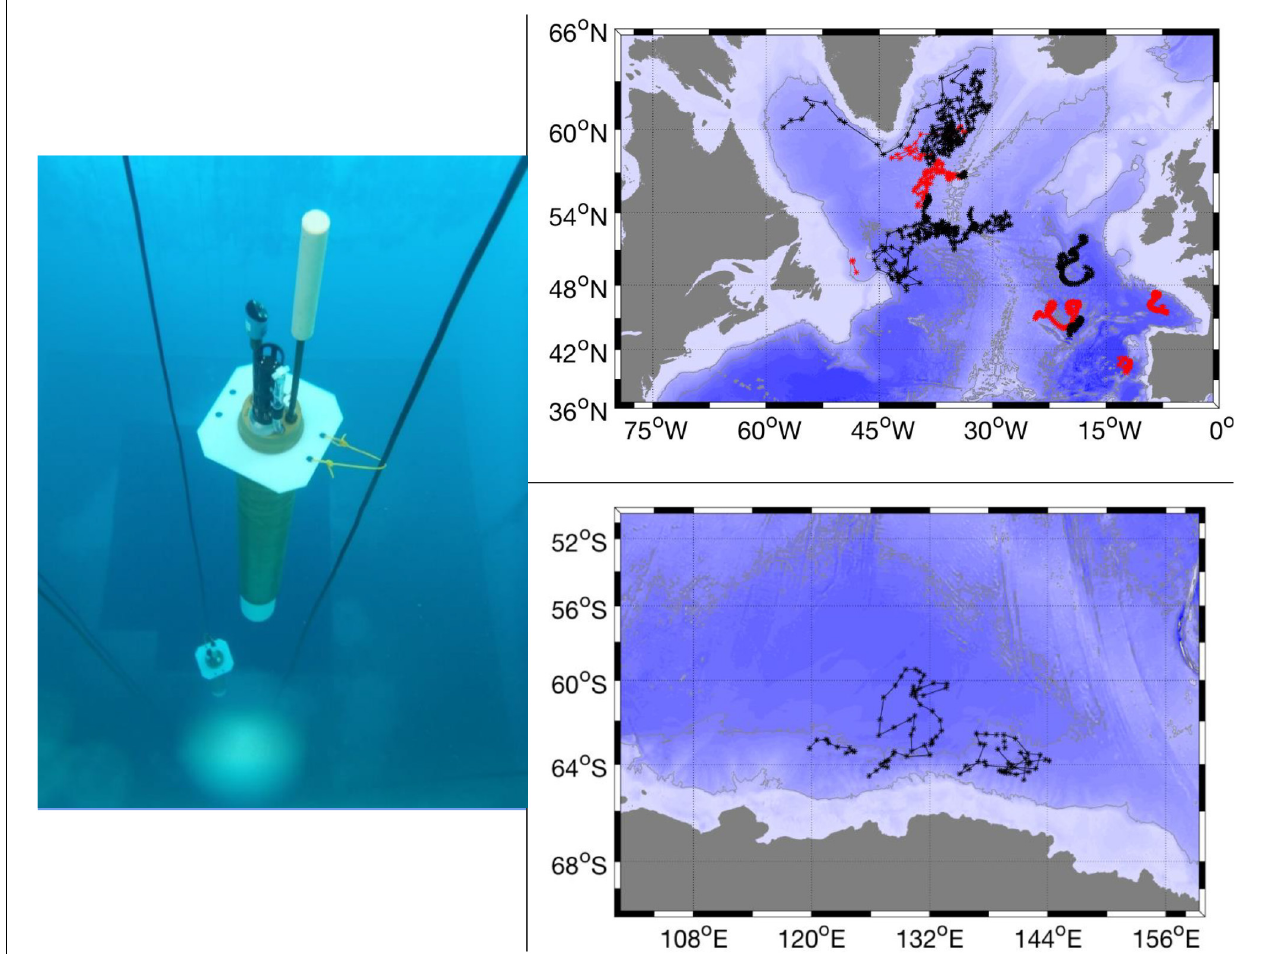
FIGURE 1 | Left : the Deep-Arvor profiling float during tests in the seawater pool at Ifremer, in May 2019 (courtesy of Noé Poffa/Ifremer). Right : trajectories of the Deep-Arvor floats deployed in the subpolar gyre of the North-Atlantic Ocean ( upper panel), and in the Southern Ocean ( lower panel). Black points: NAOS floats. Red points: floats from complementary projects or